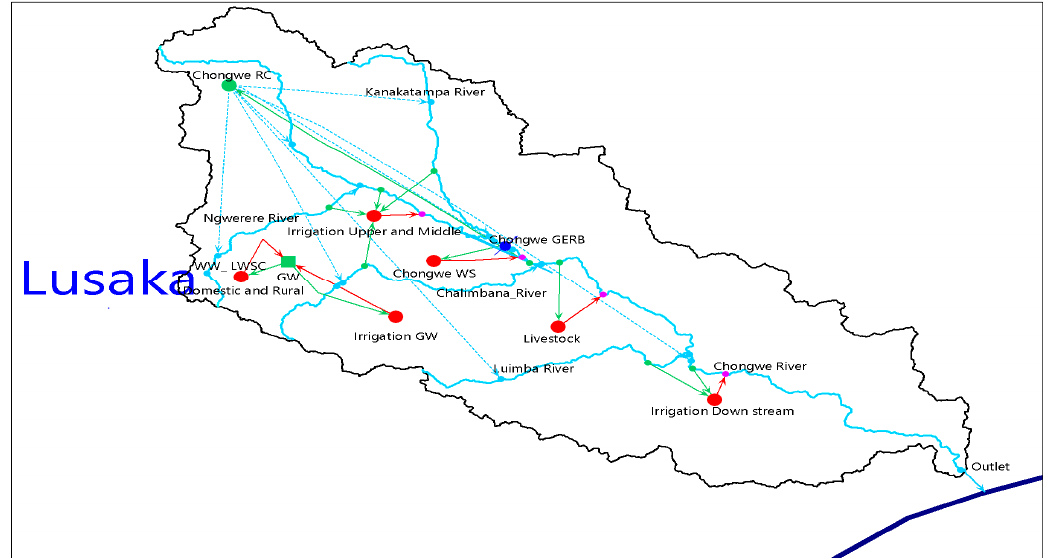
Figure 5 . WEAP schematic map for Chongwe River catchment. Figure 5. WEAP schematic map for Chongwe River